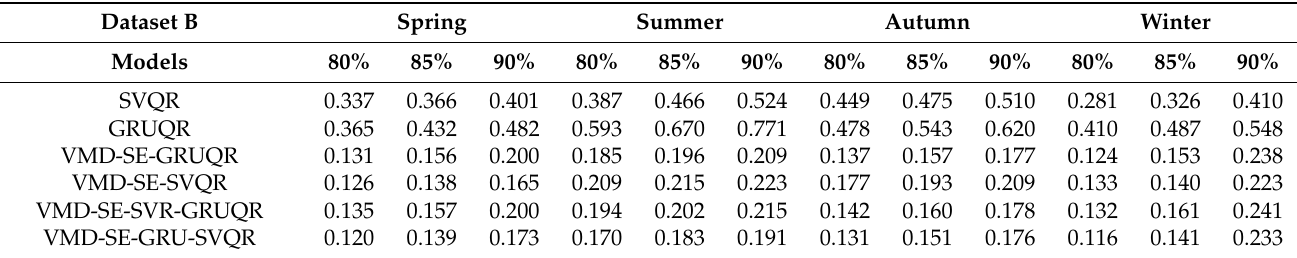
Table 6. MC values in dataset B at three confidence levels.